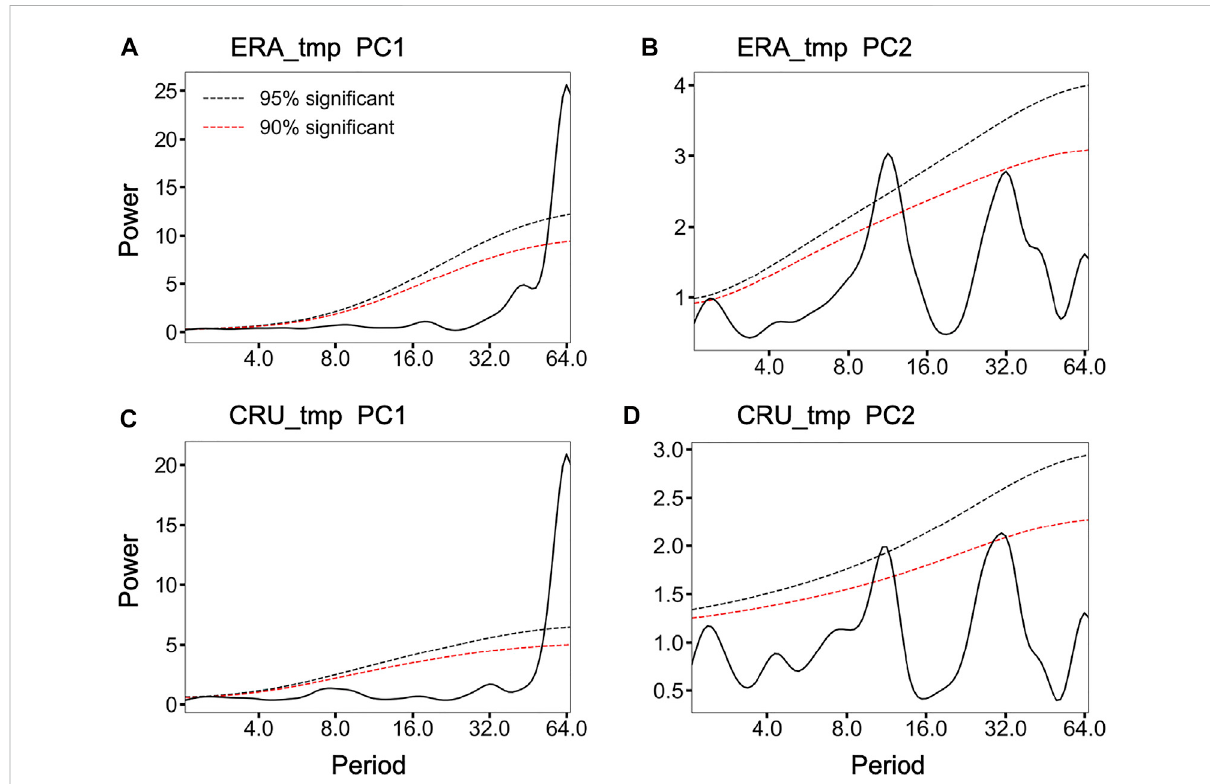
FIGURE 3 Power spectrums of the time series of the leading modes. The red (black) dashed lines indicate statistical con fi dence levels are 90% (95%). (A) ERA_tmp PC1. (B) ERA_tmp PC2. (C) CRU_tmp PC1. (D) CRU_tmp